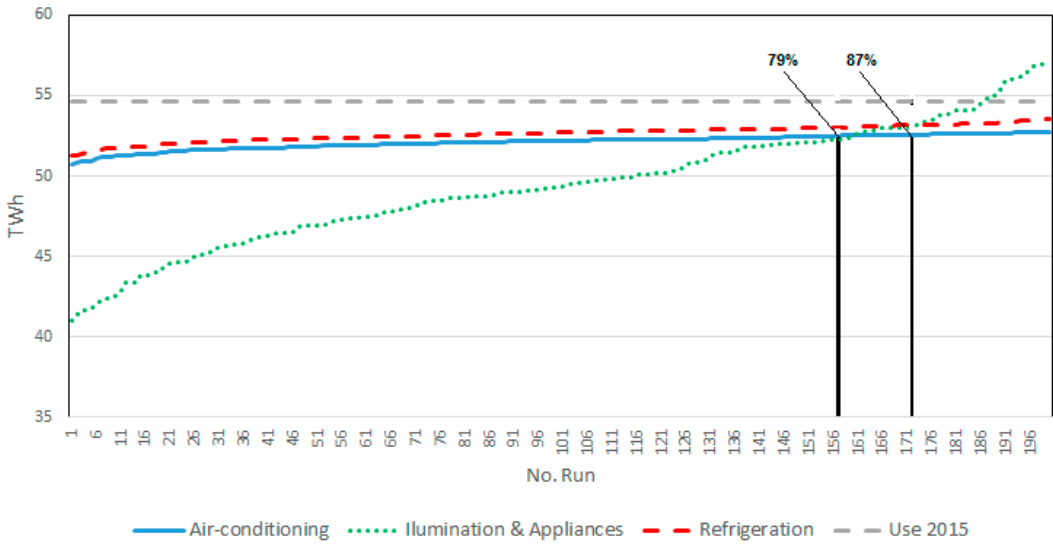
Figure 5. Estimated energy use by using efficient devices upon the Mexican residential sector.